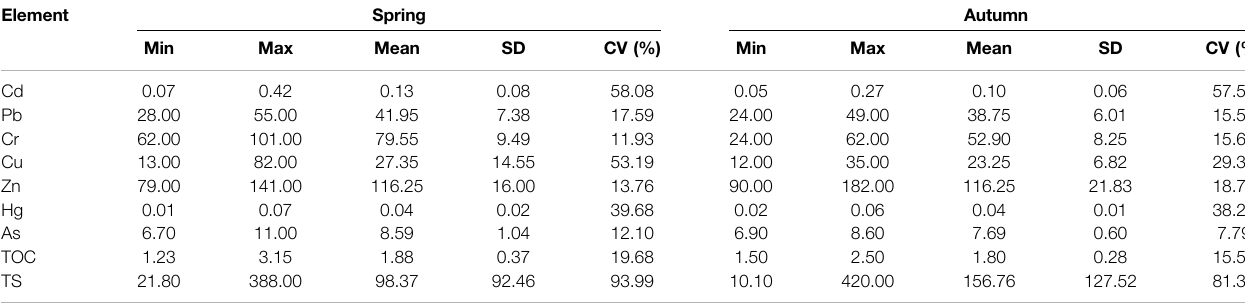
TABLE 1 | Descriptive statistics of heavy metal concentrations in surface sediments (mg/kg) in Daya Bay. Element Spring